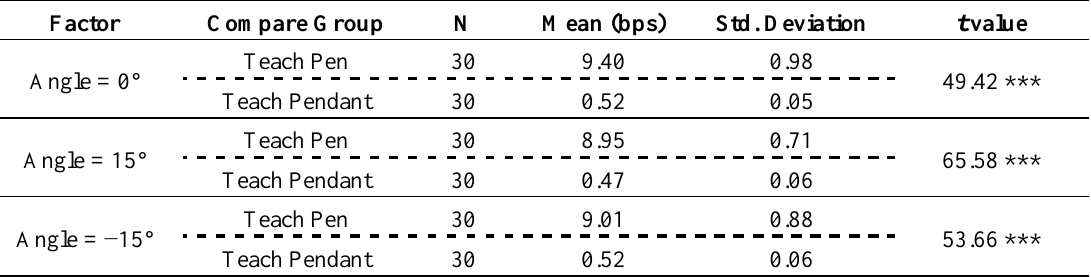
Table 9. Paired-samples t test table for the TP for operating the two